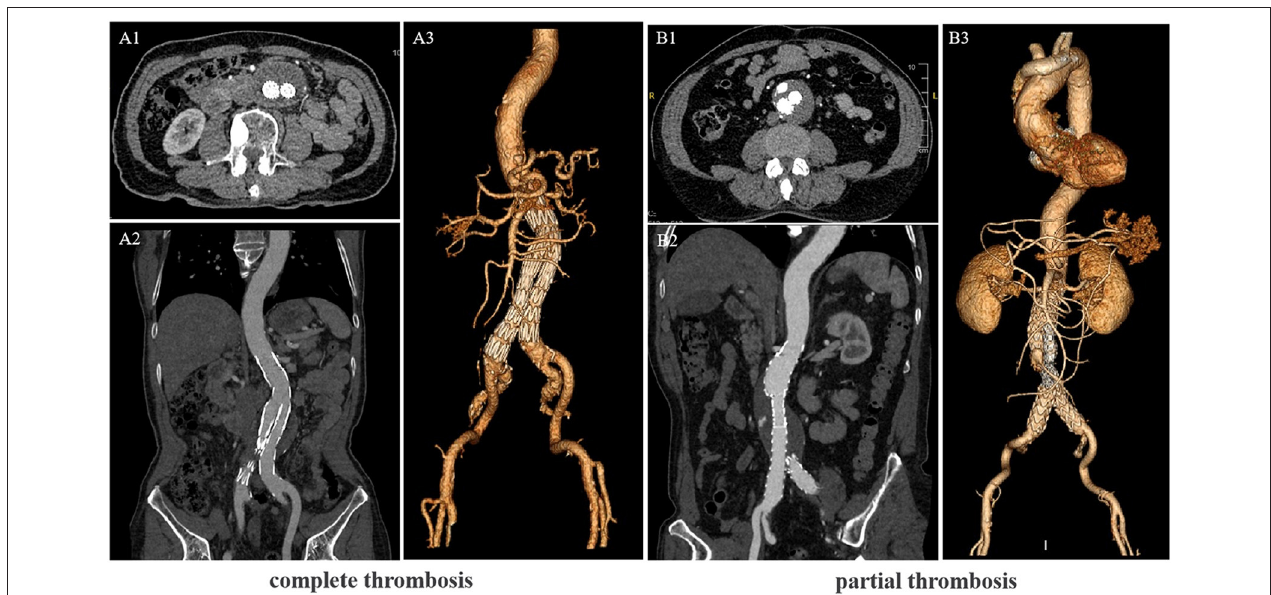
FIGURE 2 | Computed tomography angiography (CTA) scans of the Abdominal aortic aneurysm (AAA) patients after endovascular aortic repair (EVAR). (A) CTA showing the lumen complete thrombosis. (B) CTA showing the lumen partial thrombosis. (A1,B1) Cross-sectional image, (A2,B2) vertical-sectional image and (A3,B3) CTA 3D reconstruction